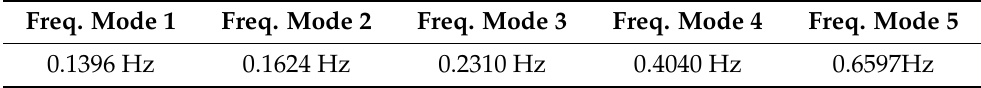
Table 6. First natural frequencies of a fully deployed DMD